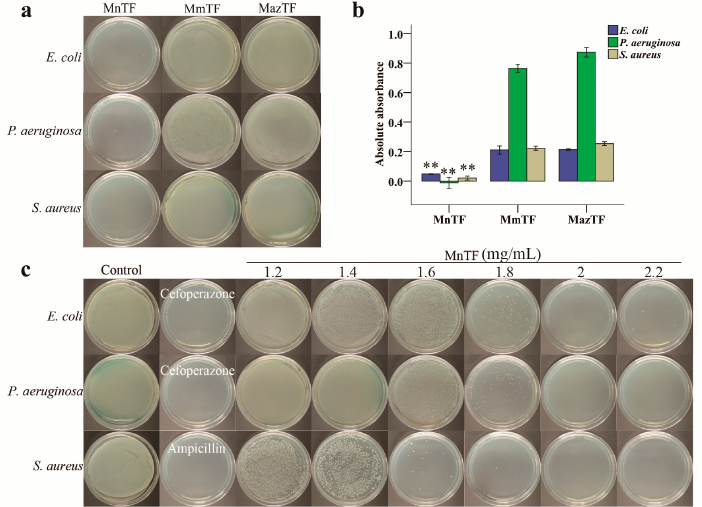
Figure 5. Antibacterial activities of TFs shown on plates ( a ) and by absorbance ( b ); and minimum bactericidal concentration (MBC) of MnTF against E. coli , P. aeruginosa and S. aureus ( c ). The concentration of TFs was 1.8 mg/mL ( a ). Data are means ± SD ( n = 3). Values with asterisks (**) are significantly different ( p < 0.01) from those in the MmTF and MazTF groups.